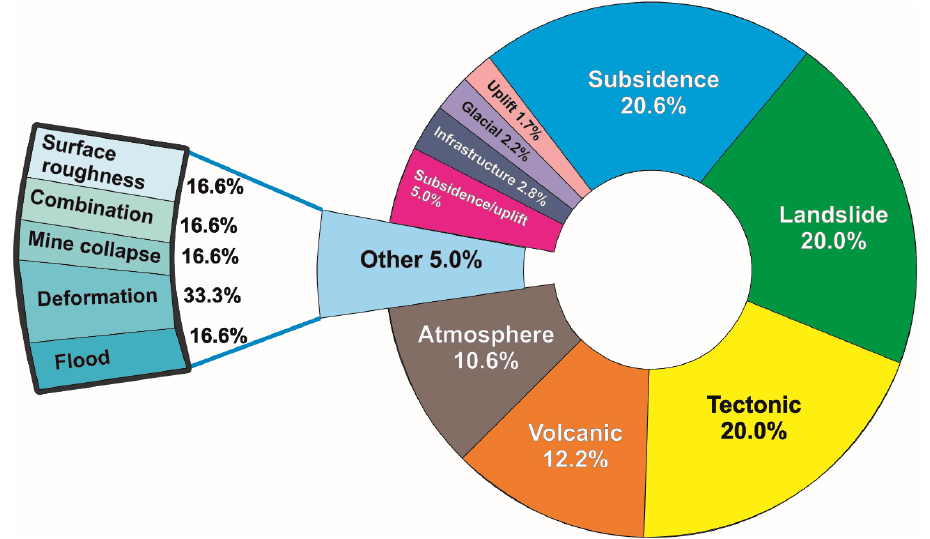
Figure 4. Distribution of the scientific works dealing with the combined use of GNSS and SAR data according to the field of application.